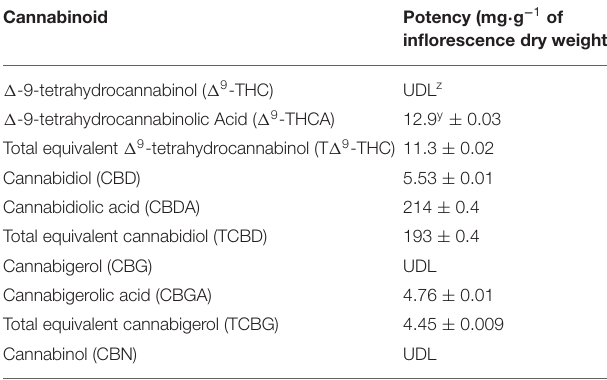
TABLE 1 | Cannabinoid potency in apical inflorescences of Cannabis sativa ‘Stillwater’. Cannabinoid Potency (mg · g − 1 of